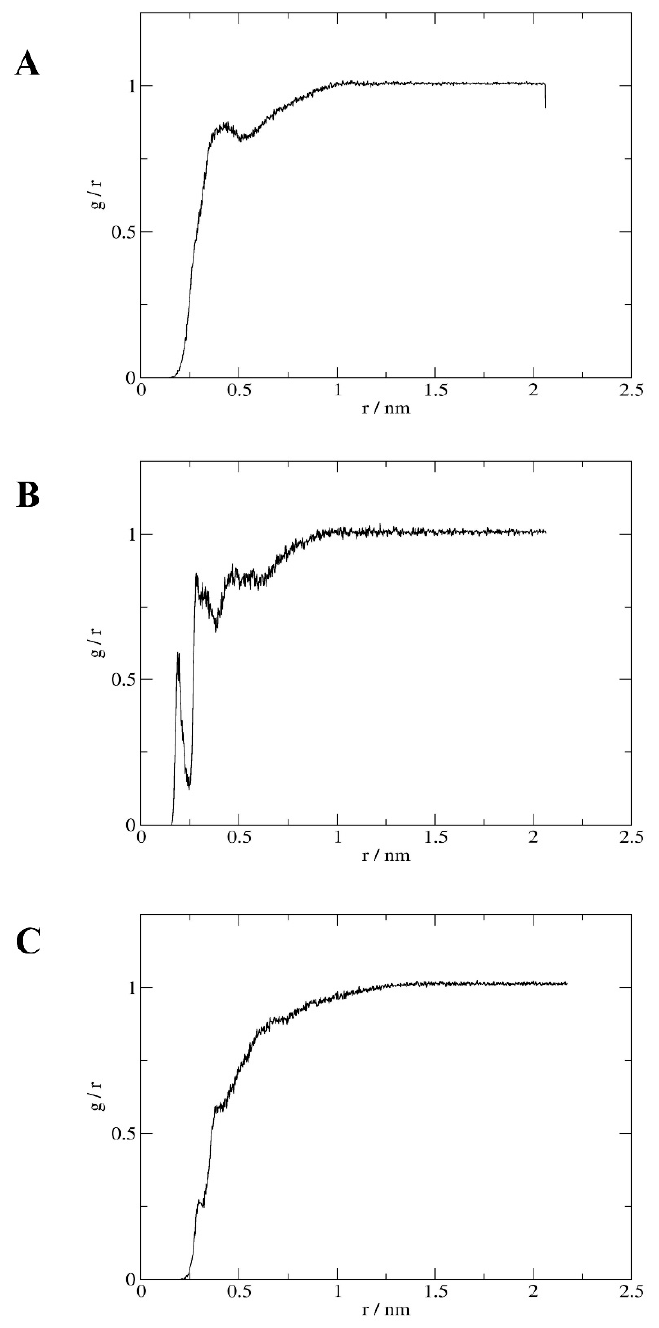
Figure A1. Radial distribution function of water from the terminal methyl, hydroxyl and disulfide moieties of Acetyl-Ala-Abu-Ala-NH 2 ( A ), Acetyl-Ala-Ser-Ala-NH 2 ( B ), and (Acetyl-Ala-Cys-Ala-NH 2 ) 2 ( C ) respectively. The probability of finding water molecules surrounding the respective moieties was determined by integrating the radial distribution function within 0.5 nm distance.